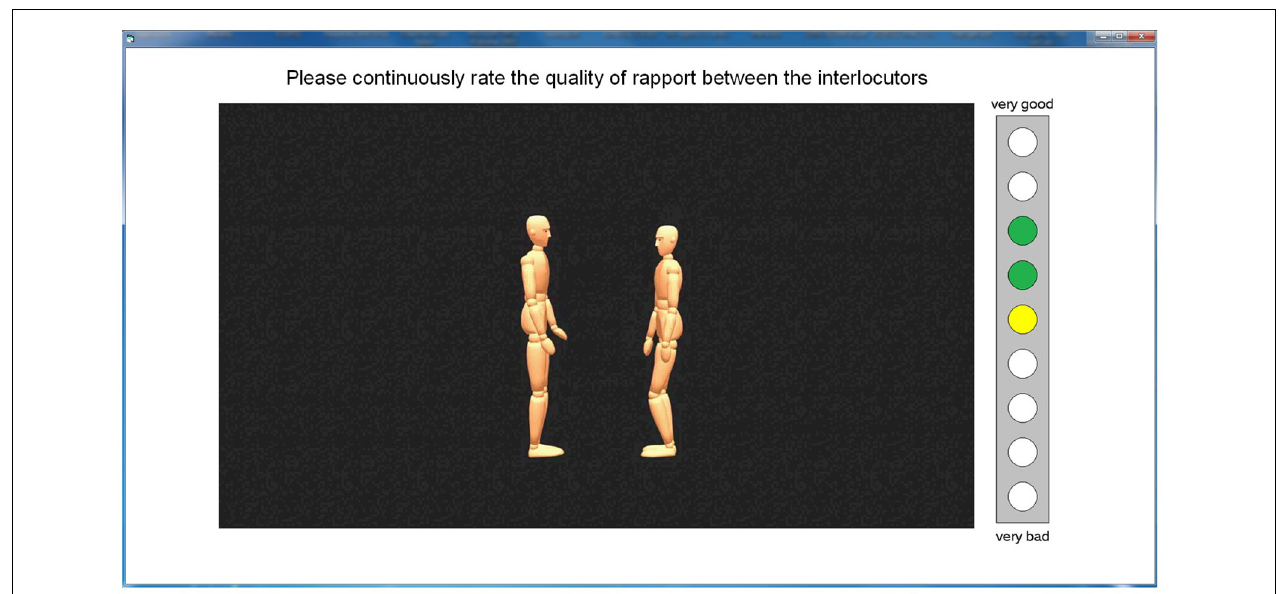
FIGURE 2 | Screenshot of the user interface for the continuous judgment of rapport (description in the text).